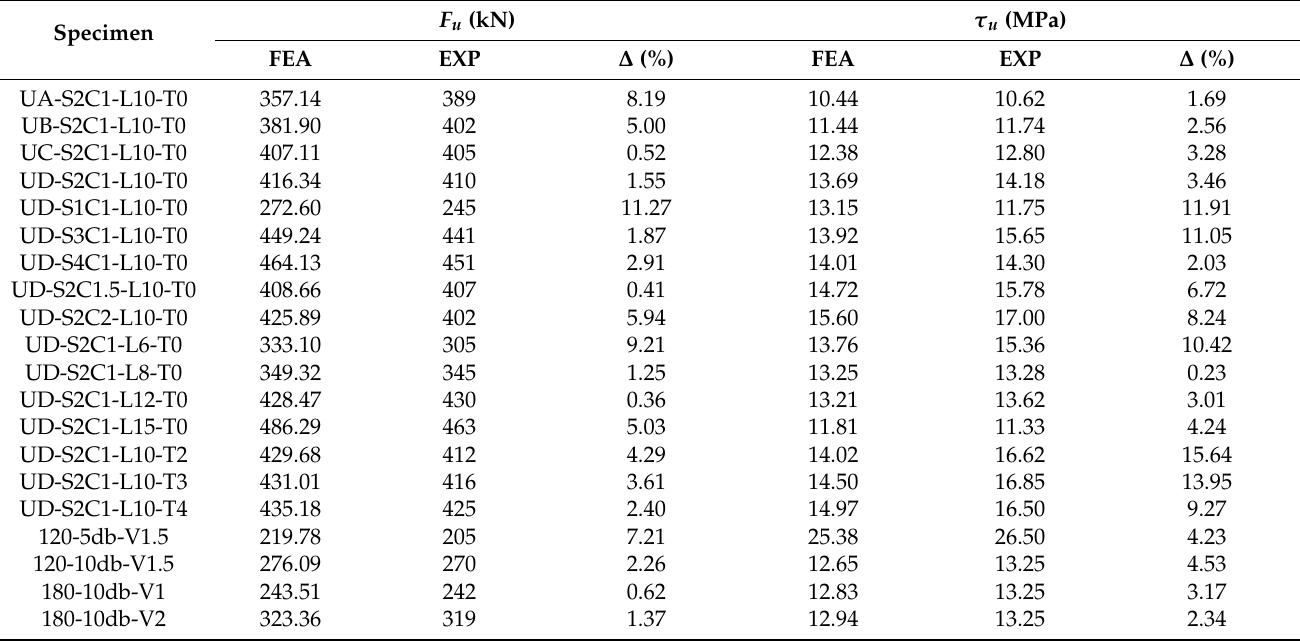
Table 6. Summary of peak load and bond strength.